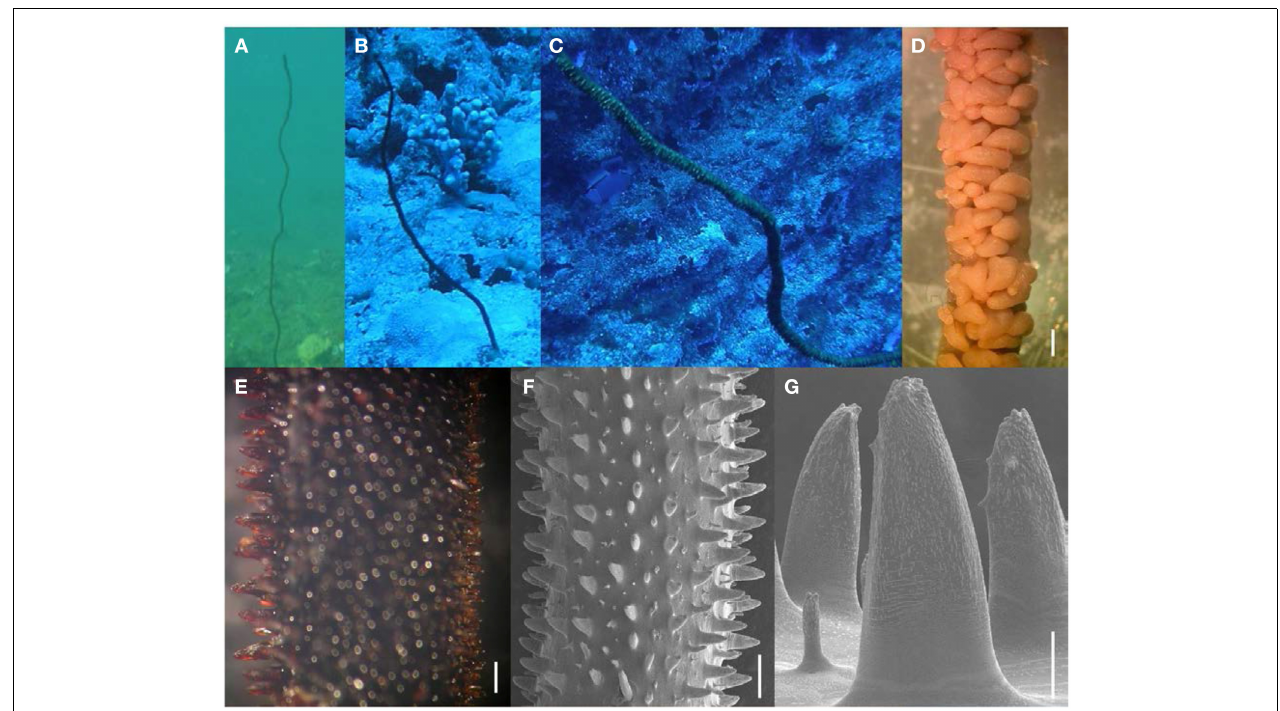
FIGURE 5 | Stichopathes ? sp. (A–C) in situ ; (D) preserved polyps under light microscopy (scale bar = 1mm); (E) skeletal spines under light microscopy (scale bar = 500 μ m); (F) skeletal spines under SEM (scale bar = 500 μ m); and (G) close-up of polypar spines under SEM (scale bar = 100 μ